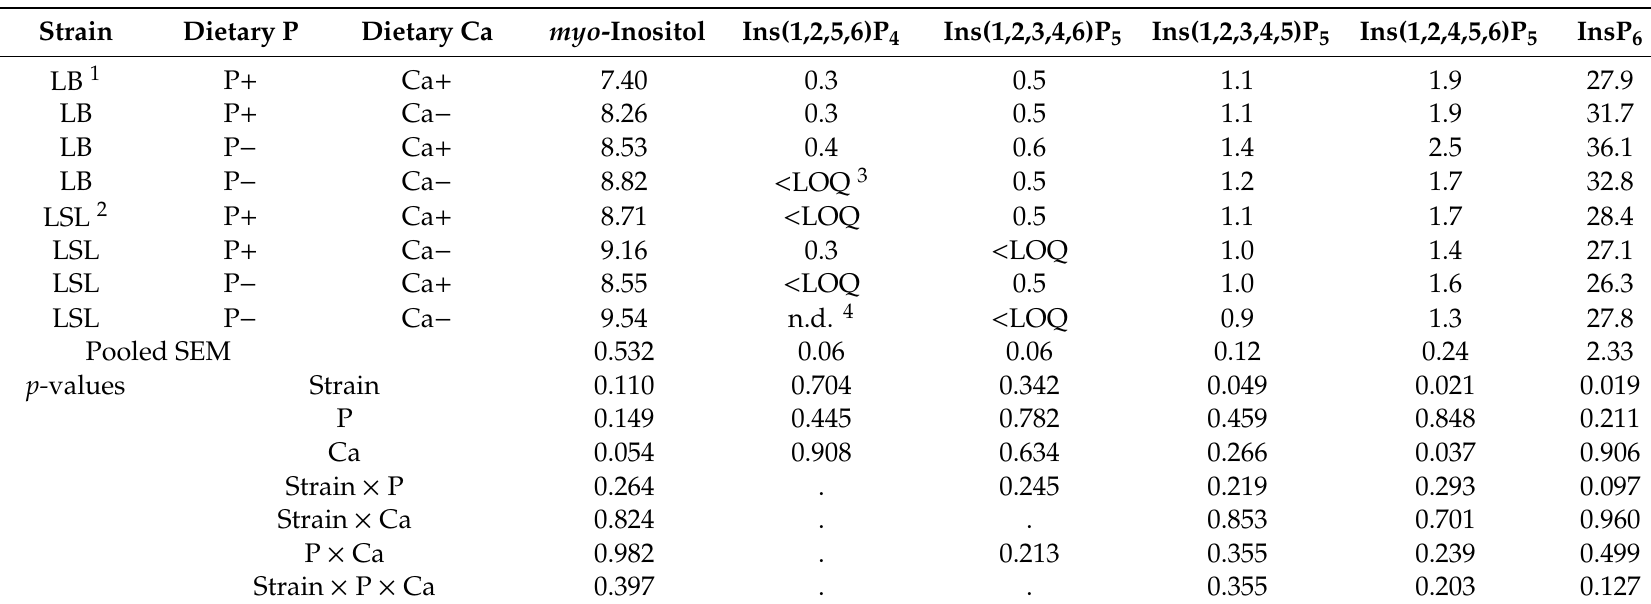
Table 4. E ff ect of strain, P, and Ca on concentrations of myo -inositol and InsP isomers in the jejunum of laying hens aged 31 weeks ( µ mol /